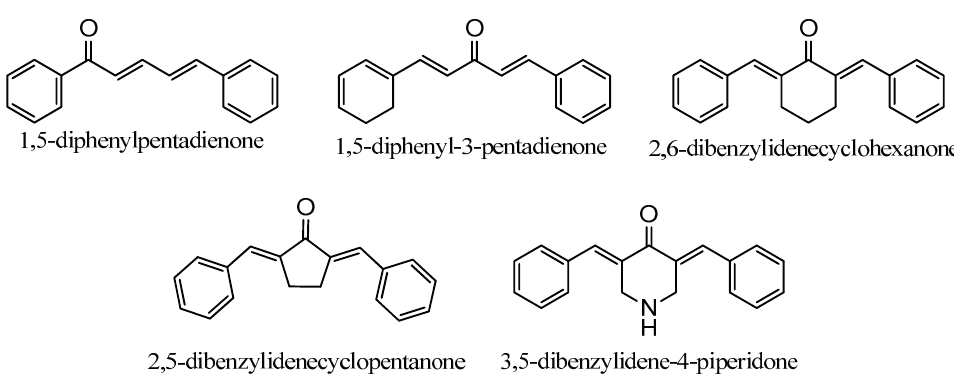
Figure 1. General structures of diarylpentanoid derivatives.